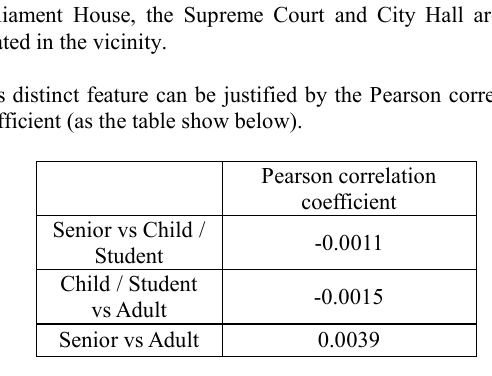
Table 3. Pearson correlation coefficient of short